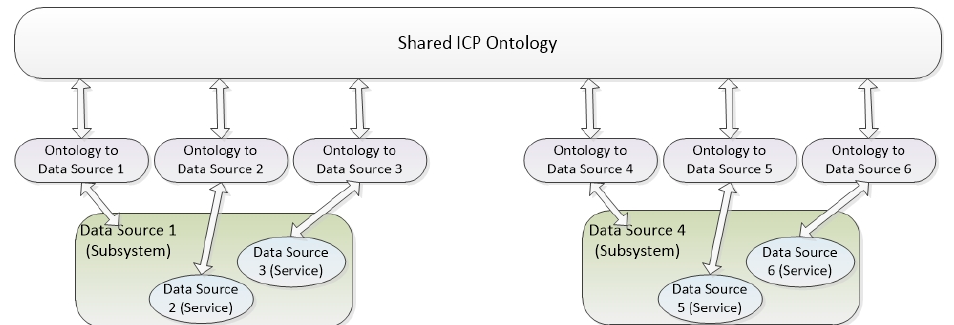
Figure 2. Integration system regarding Semantic Interoperability.